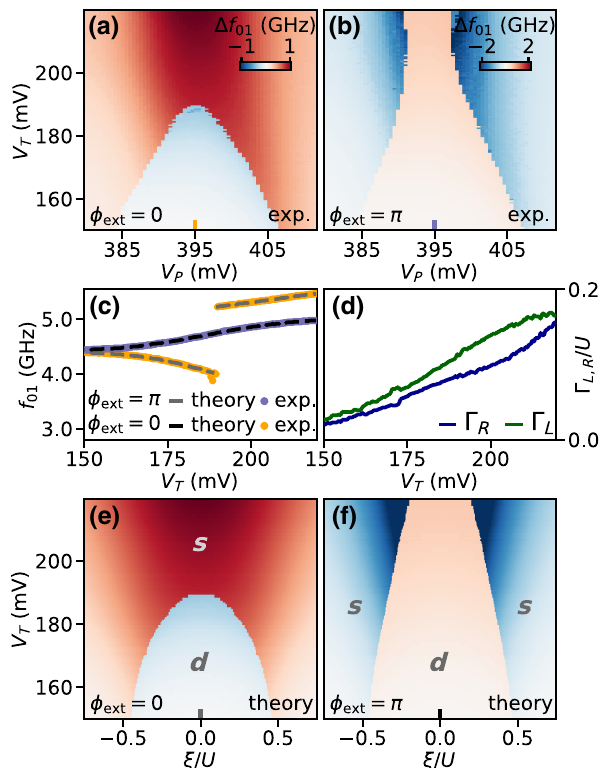
FIG. 5. The tunnel gate dependence. (a) (cid:9) f 01 versus V P and V T at φ ext = 0, where V T is a virtual gate voltage defined as a linear combination of V C and V R (see text). The blue region corre- sponds to a negative supercurrent contribution from the quantum dot junction, while the red region corresponds to a positive con- tribution. (b) The same measurement as (a) repeated for φ ext = π . (c) Line cuts of (a) and (b) at V P = 395 mV overlaid with best fits based on NRG calculations. (d) The extracted dependence of (cid:6) L , R on V T . (e) The calculated transmon frequencies based on NRG calculations at φ ext = 0 as matched to the measured data, with the V T axis as given in (d). The color bar is shared with (a). (f) The same as (e) but for φ ext = π , with the same color bar as (b). For the NRG calculations in (c)–(f) we fix (cid:9)/ h = 46 GHz and U /(cid:9) =